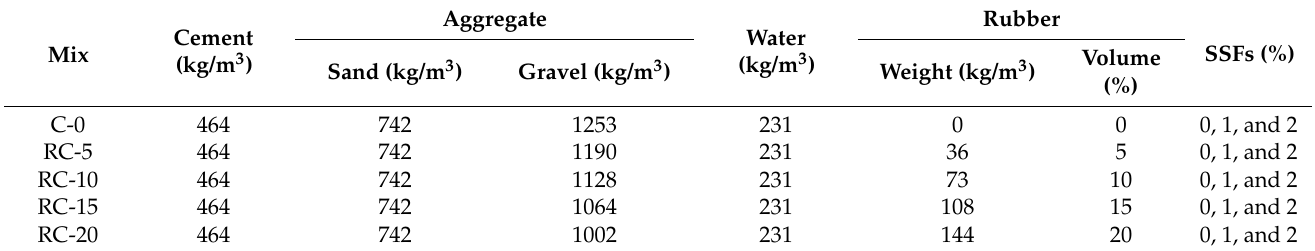
Table 1. Ratios of the concrete mix ingredients.